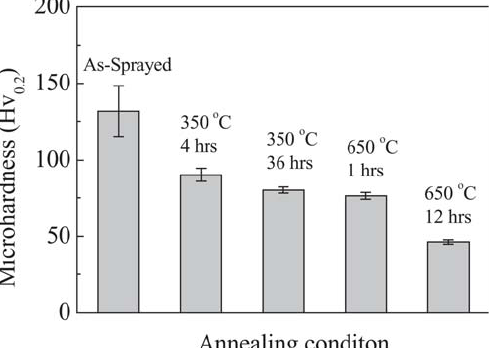
Figure 10: The effect of annealing on microhardness of the coated specimen